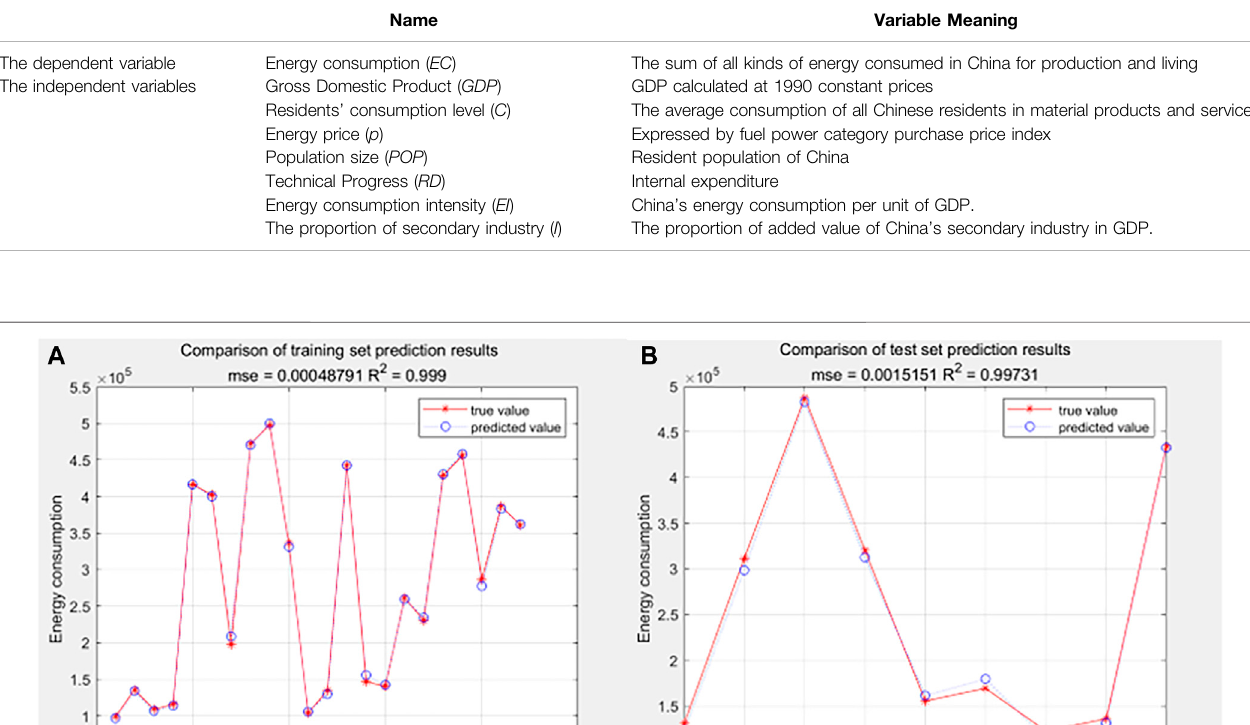
TABLE 2 | Variables and their meanings.